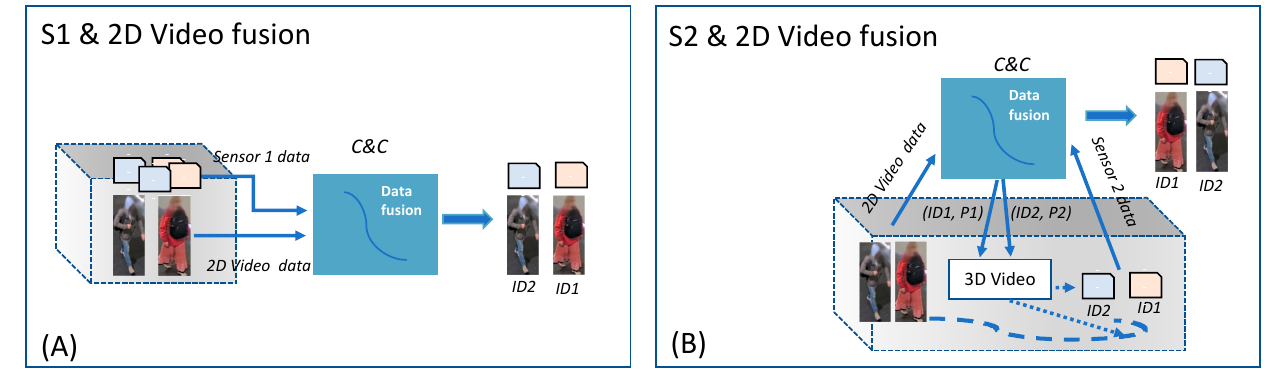
Figure 6 . C&C methods for 2D Video sensor data fusion: ( A ) time-based: Sensor 1 (S1) and 2D Video observe objects and persons situated at a pre-defined location; ( B ) Identity-based: 2D Video-C&C and 3D Video tracking handover allow one to locate (re) identified persons for Sensor 2 (S2) detection .